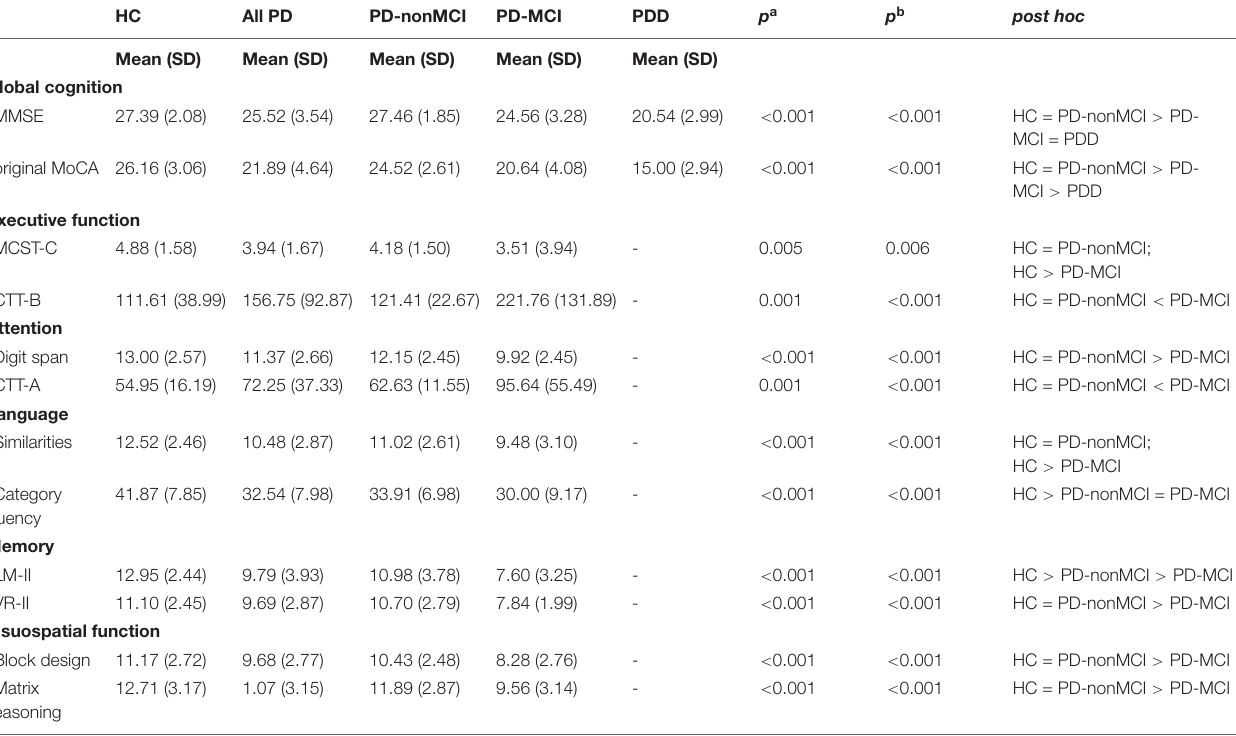
TABLE 5 | Neuropsychological performance in study groups.